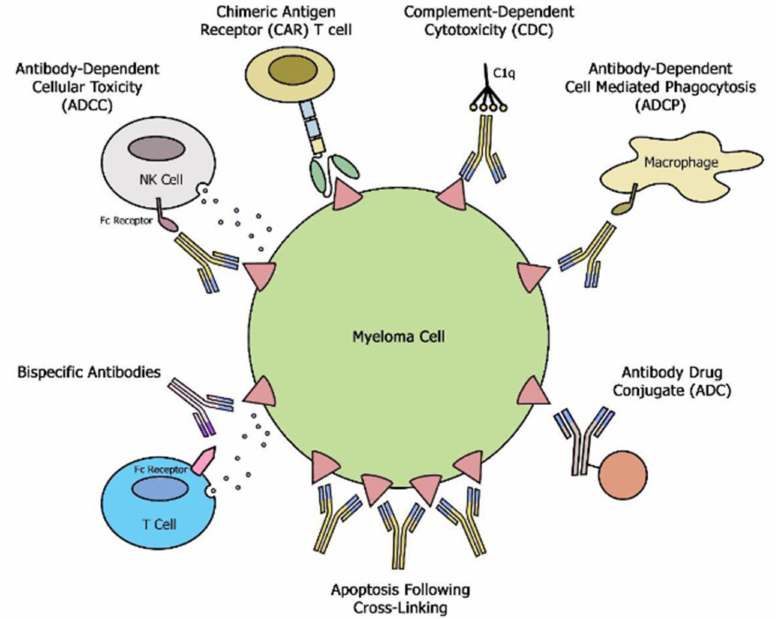
Figure 1. Schematic overview of different mechanisms exerted by moAbs, bsAbs and CAR T